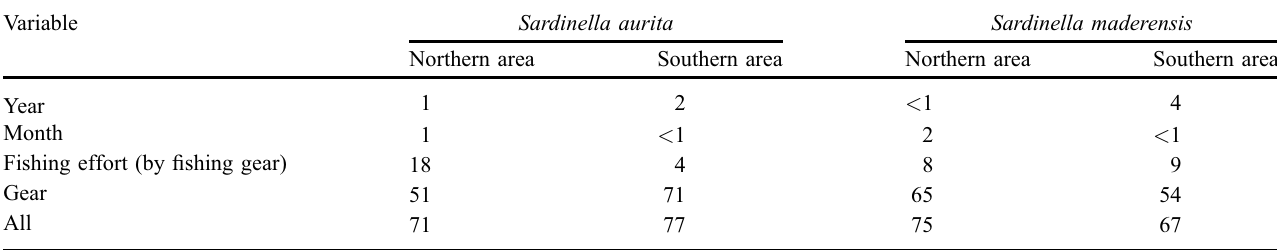
Table 2. Percent of explained deviance by each covariate tested for explaining variations in the monthly landing of Sardinella aurita and Sardinella maderensis in two areas in Senegalese waters. The p -values for all variables are < 0.01.